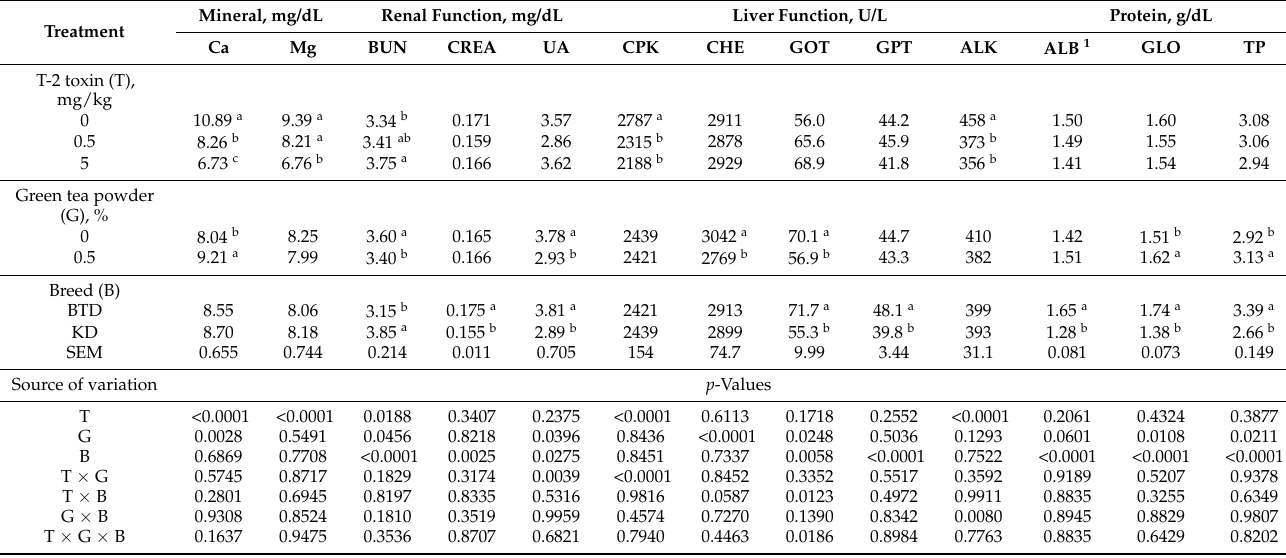
Table 4. Effects of diets containing T-2 toxin and green tea powder on plasma biochemical values of Brown Tsaiya ducklings and Kaiya